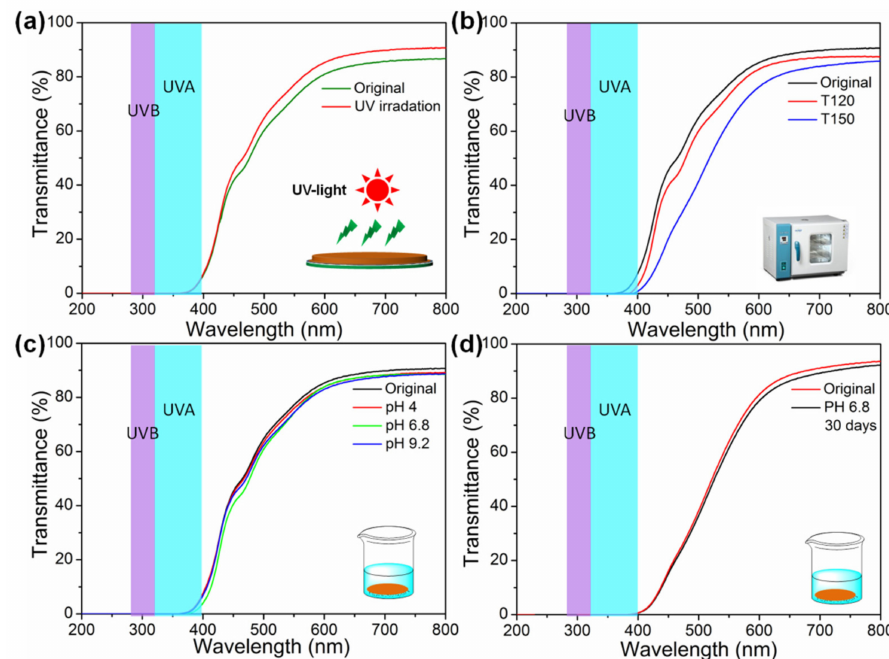
Figure 7. ( a ) Effect of UV irradiation for 6 h on the UV blocking performance of M(Fe)CCF1; ( b ) Effect of heat treatment (120 and 150 ◦ C) for 2 h on the UV blocking performance of M(Fe)CCF1; ( c ) Effect of pH value on the UV blocking performance of M(Fe)CCF1; ( d ) Effect of soaking in water (pH = 6.8) for 30 days on the UV blocking performance of